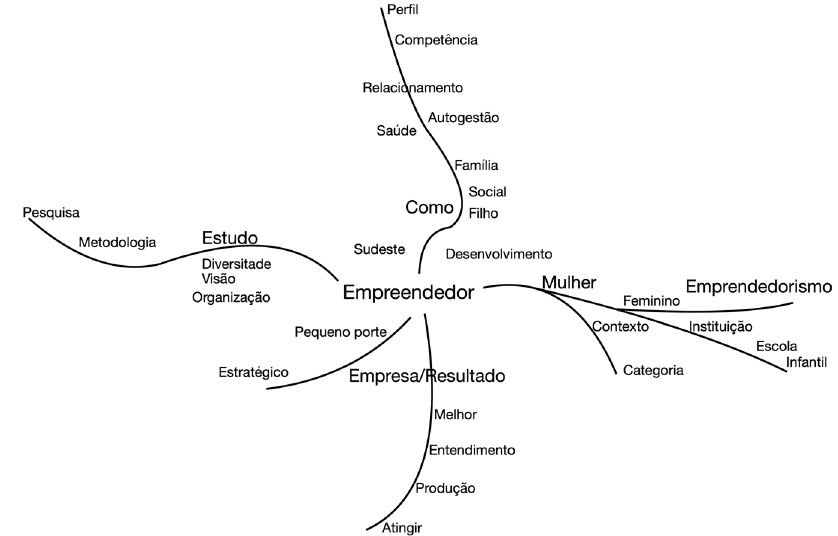
Fig. 3 Tree diagram of links between lexical classes of words in papers published in Portuguese.